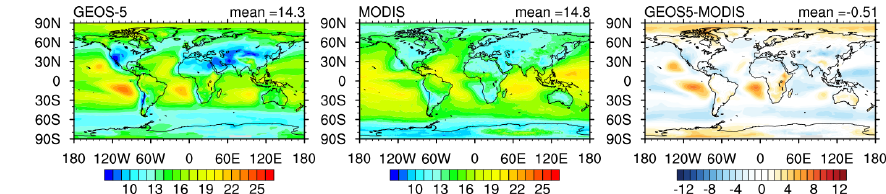
Figure 12. Liquid cloud effective radius (µm) from GEOS-5 (NEW run) using COSP and from the MODIS retrieval.